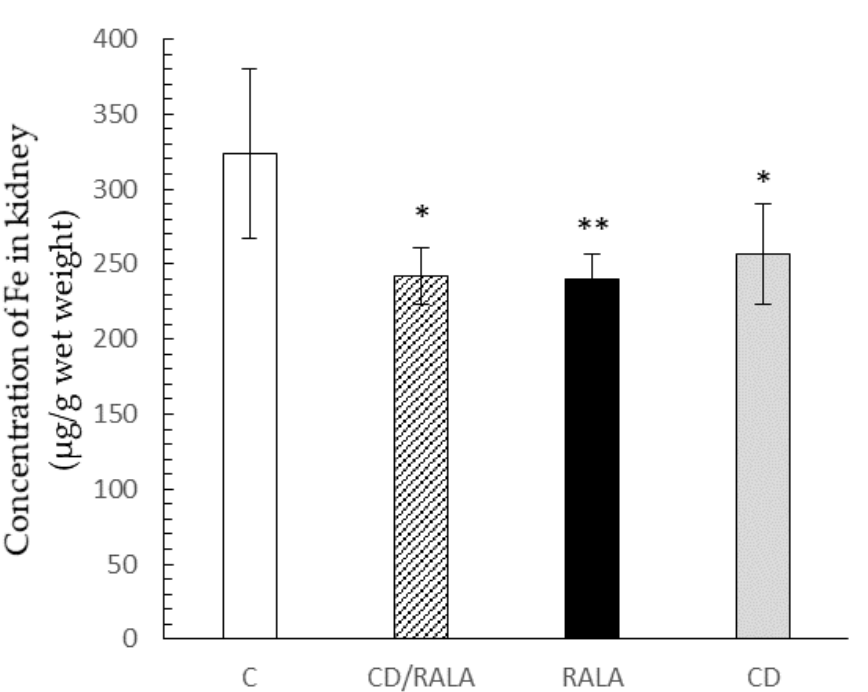
Figure 6. Concentration of Fe in the kidney. Values are expressed as the mean ± SD for six mice in each group. C, control group; CD/RALA, R- α -lipoic acid γ -cyclodextrin complex group; RALA, R- α -lipoic acid group; CD, γ -cyclodextrin group. ** p < 0.01 vs. C, * p < 0.05 vs. C. Table 4. Other experiments. Experimental